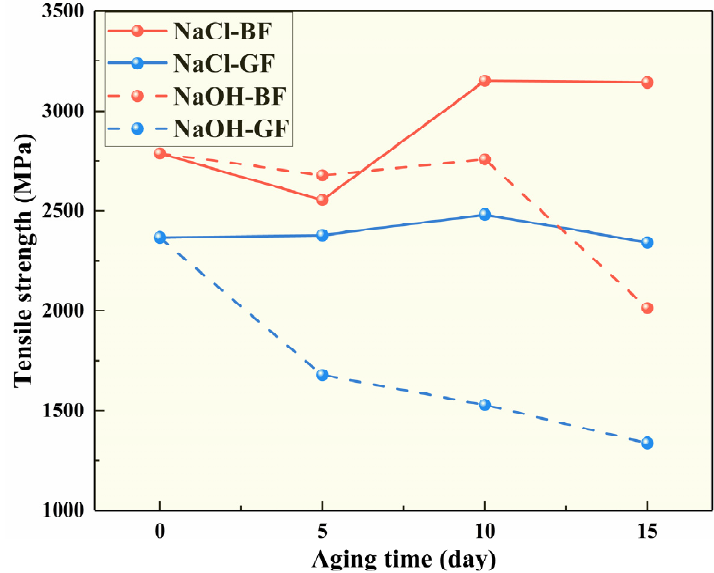
Figure 6. Salt alkali aging test results of different fibers.